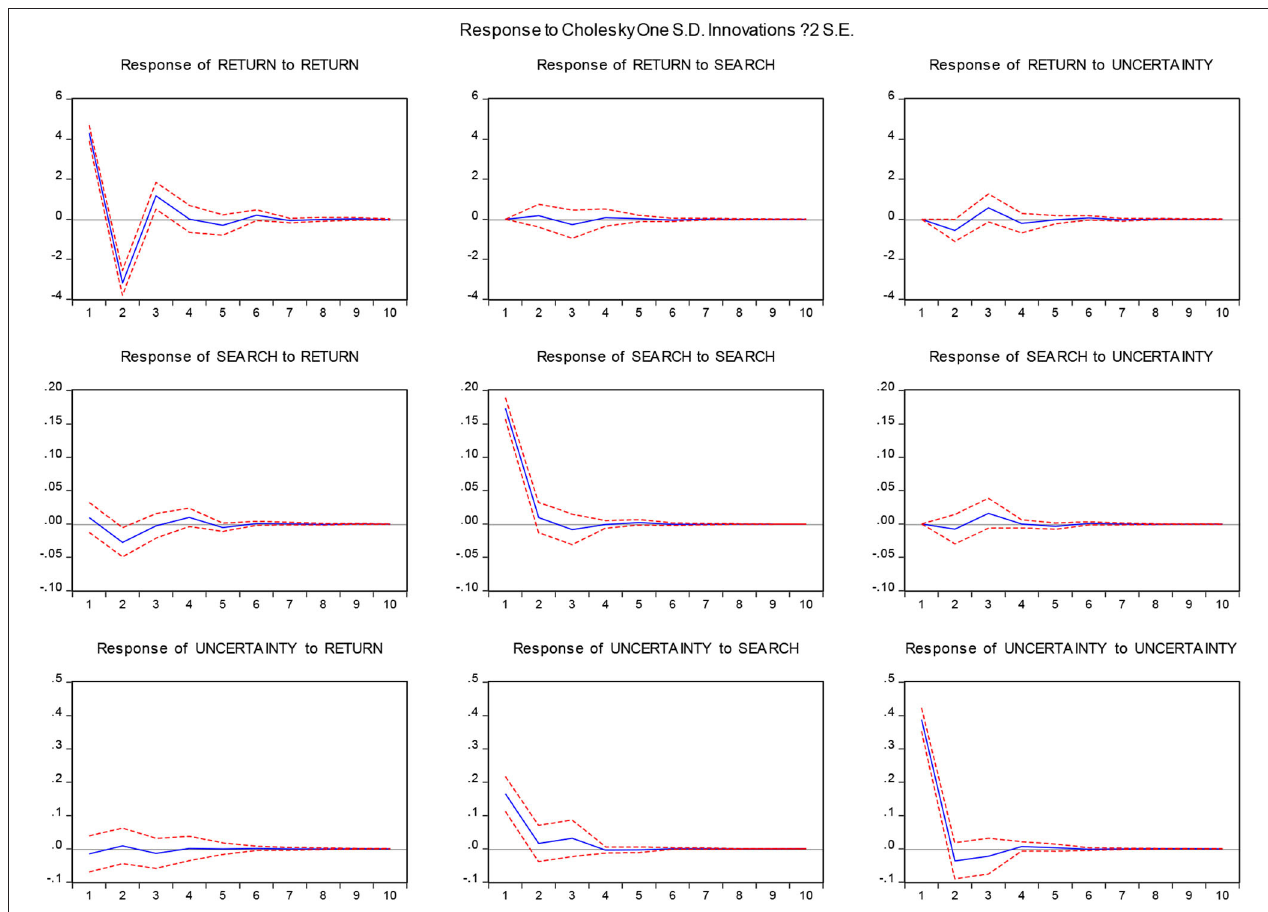
FIGURE 1 | Impulse response function among main